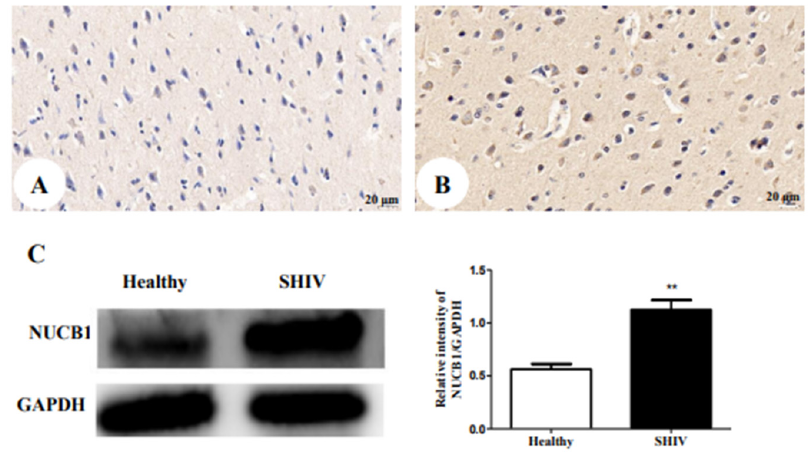
Figure 3. NUCB1 protein expression in cerebral cortex: ( A ) the healthy control (400 × ); ( B ) SHIV KU-1 -infected monkey (400 × ) ( C ) comparison of NUCB1 expression of cerebral cortex in healthy control and SHIV KU-1 -infected monkey using Western blotting. In the column, from the t test, statistically significant differences of the two groups can be determined ( p = 0.0056). ** p < 0.01.